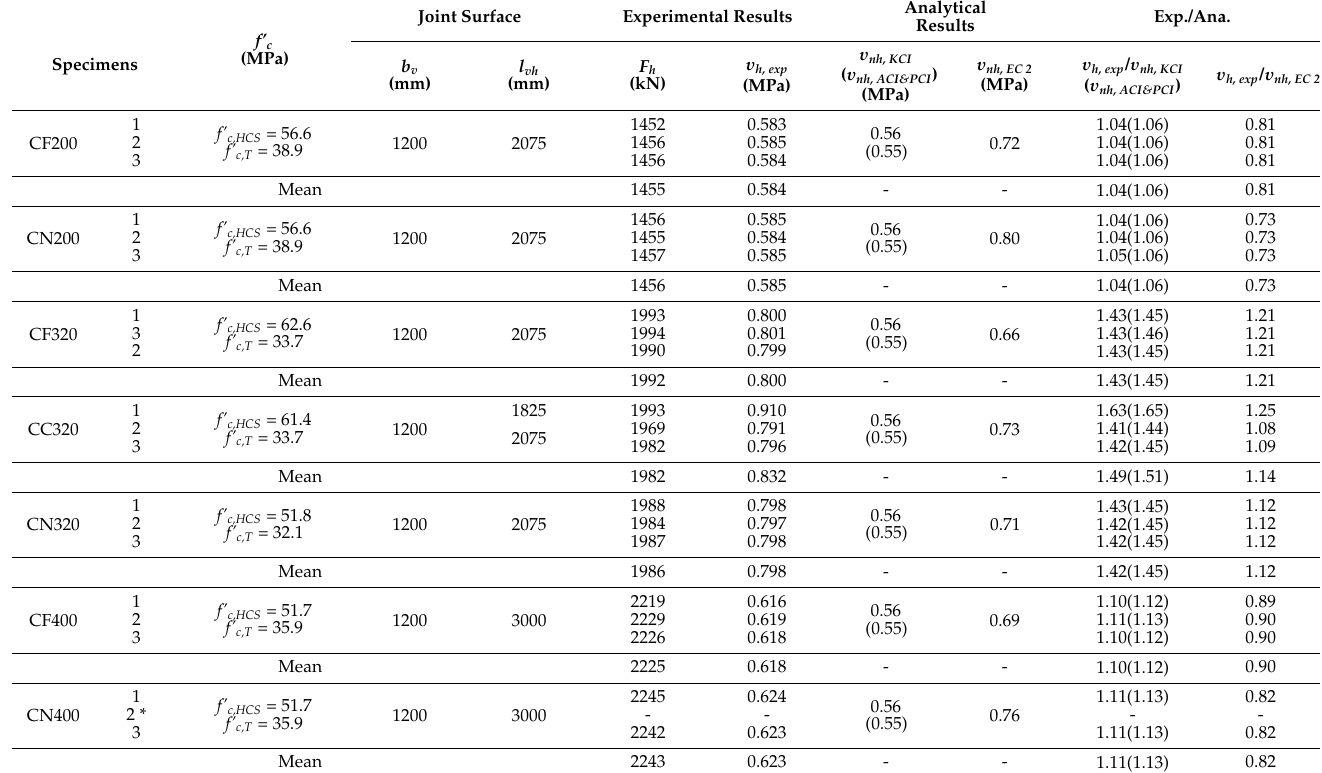
Table 4. Comparison of horizontal shear